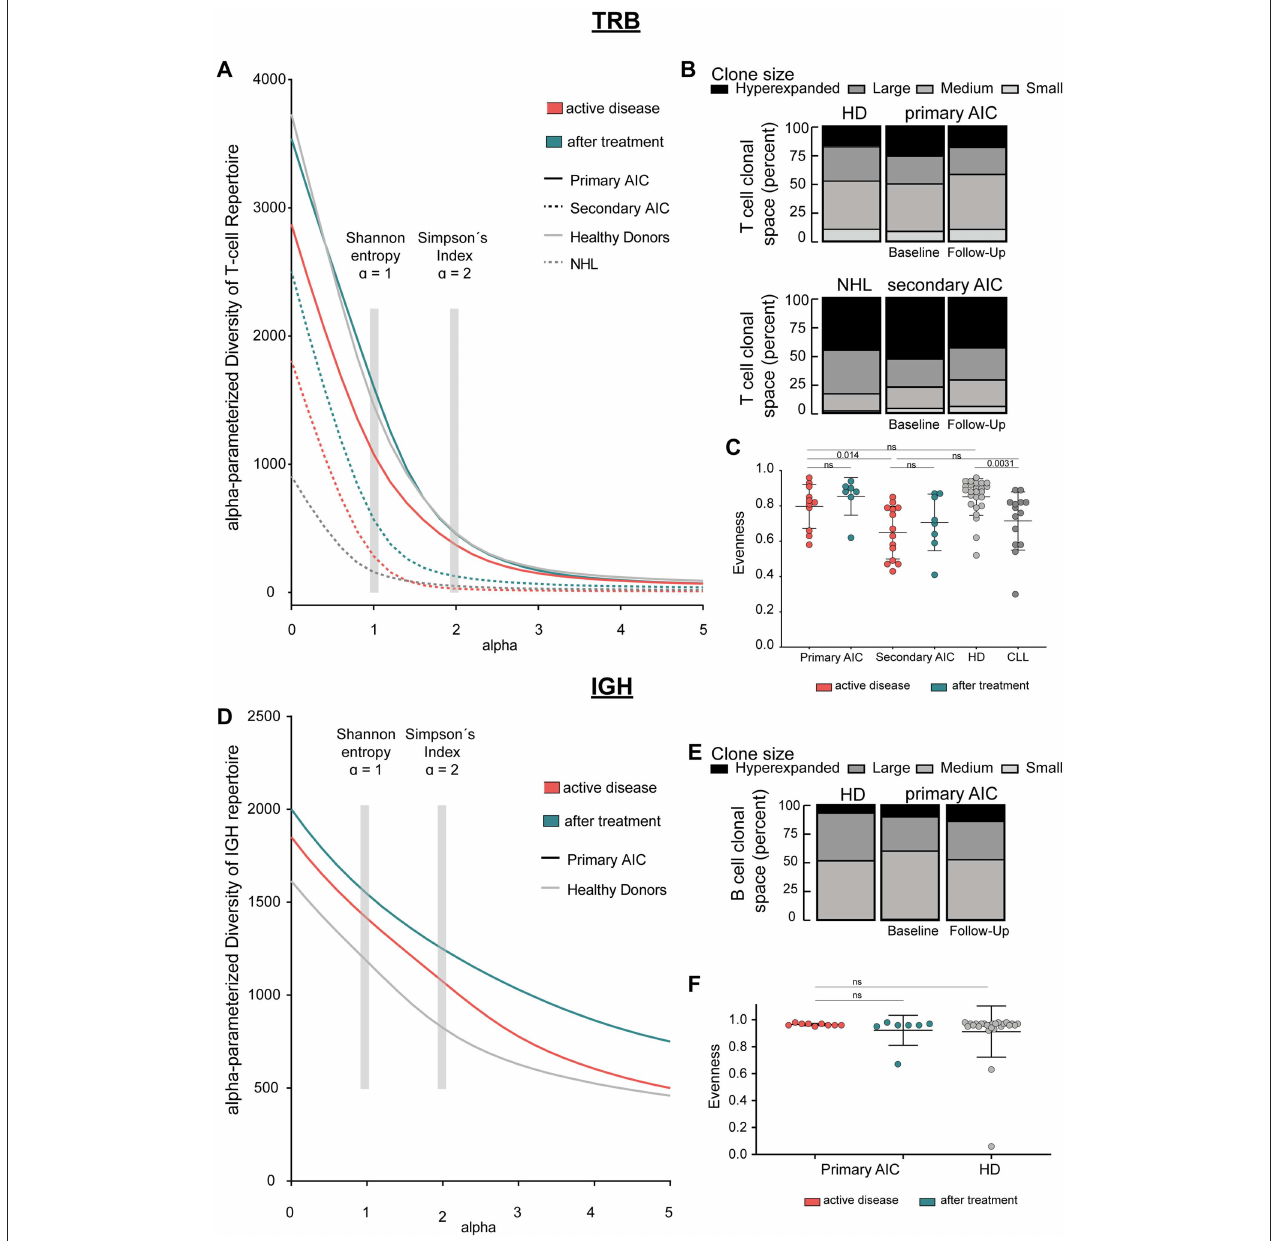
FIGURE 1 | Immune repertoire metrics. (A) Alpha-parameterized diversity of TRB repertoire. The mean diversity profile curves of TRB repertoires at active disease and after treatment samples of patients with primary and secondary AIC, respectively, and HD and patients with CLL are shown. (B) Clonal T cell space of patients with primary and secondary AIC at active disease and after treatment, respectively, HD and patients with CLL. The distribution of small, medium, large, and hyperexpanded clones in % within the clonal T cell space is shown. (C) TRB Evenness (mean ± standard deviation) of patients with primary and secondary AIC at active disease and after treatment, respectively, HD and patients with CLL. (D) Alpha-parameterized diversity of IGH repertoire. The mean diversity profile curves of IGH repertoires at active disease and after treatment samples of patients with primary AIC and HD are shown. (E) Clonal B cell space of patients with primary AIC at active disease and after treatment and HD. The distribution of small, medium, large, and hyperexpanded clones in % within the clonal B cell space is shown. (F) IGH Evenness (mean ± standard deviation) of patients with primary AIC at active disease and after treatment and HD. Clone sizes are defined as hyperexpanded (0.01 < x ≤ 1), large (0.001 < x ≤ 0.01), medium (1E-04 < x ≤ 0.001), small (1E-05 < x ≤ 1E-04). Gray boxes highlight alpha = 1, which resembles Shannon-Index, alpha = 2, which resembles Simpson’s Index. Statistical analysis: Two-sided unpaired t -test. Sample sizes in all panels are: Active disease primary AIC ( n = 11), secondary AIC ( n = 14); after treatment primary AIC ( n = 7), secondary AIC ( n = 8); HD ( n = 25), and patients with CLL ( n = 14).